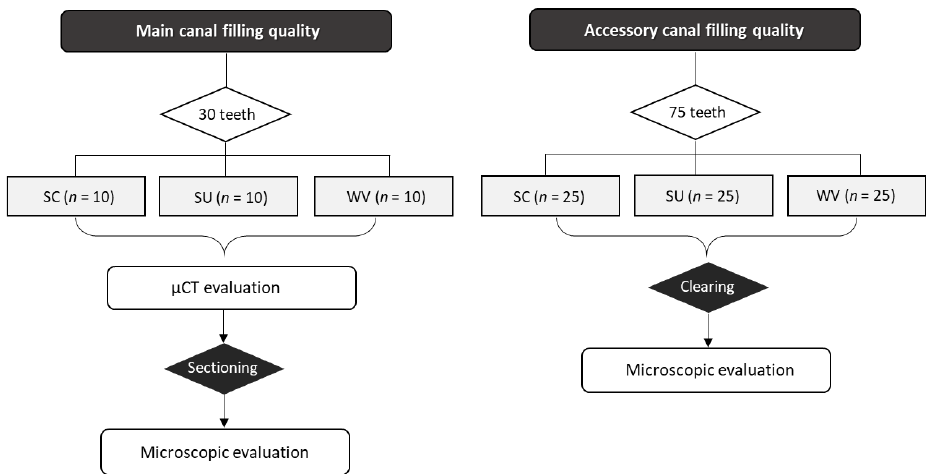
Figure 1. Flowchart representing the experimental procedure. SC: single-cone technique, SU: single- Figure1. Flowchartrepresentingtheexperimentalprocedure. SC:single-conetechnique, SU:single-cone cone technique with ultrasonic activation, WV: warm vertical compaction. technique with ultrasonic activation, WV: warm vertical